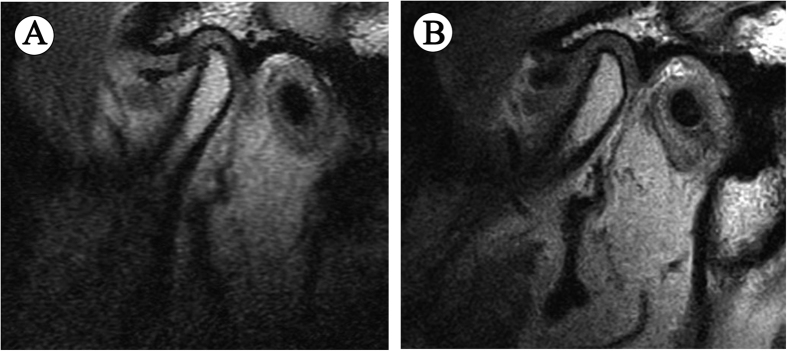
MRI scans of a 55-year-old male ADDWoR patient with the interval of 11 months, showing significant deterioration of disc status.(A) First visit, (B) Follow-up visit.